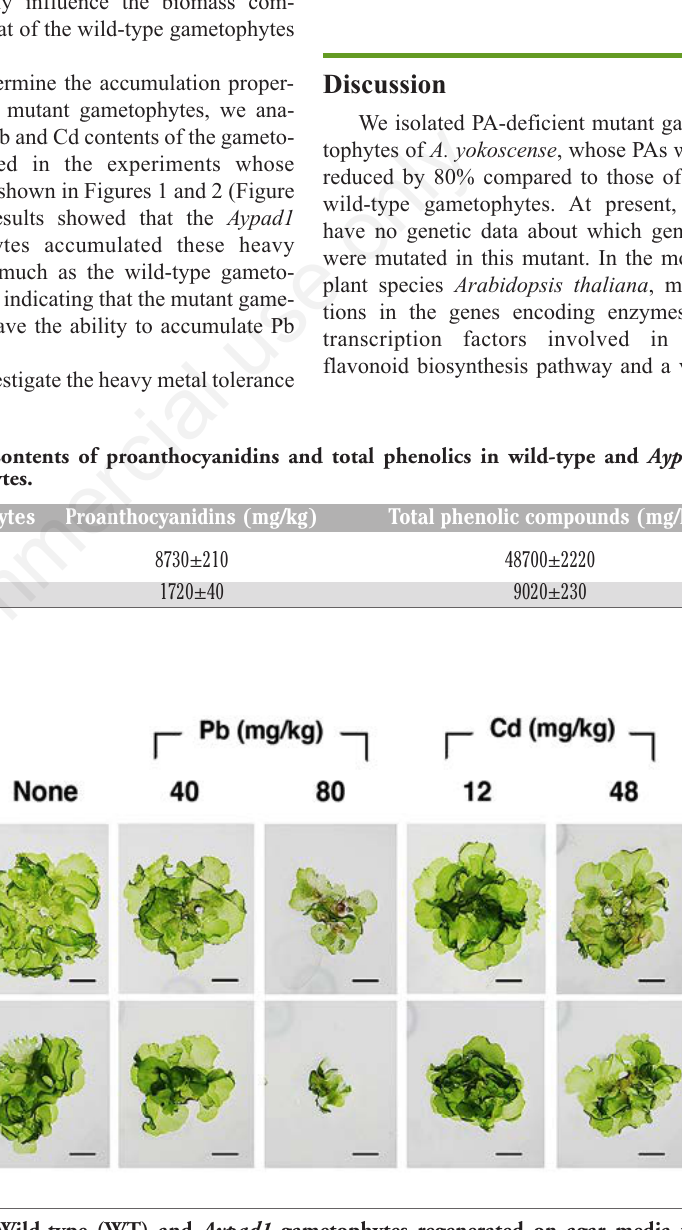
Figure 1. Wild-type (WT) and Aypad1 gametophytes regenerated on agar media that included Pb or Cd. Small fragments (~5 mm 2 ) of the gametophytes were precultured